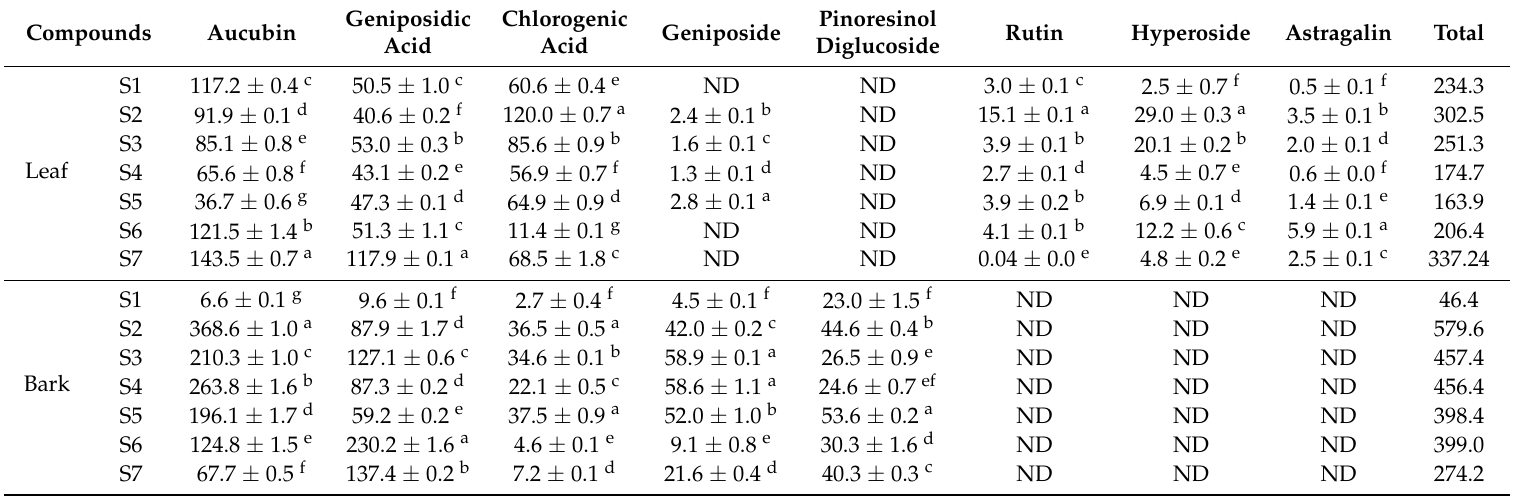
Table 3. Contents of the eight compounds of leaf and bark of different E. ulmoides varieties